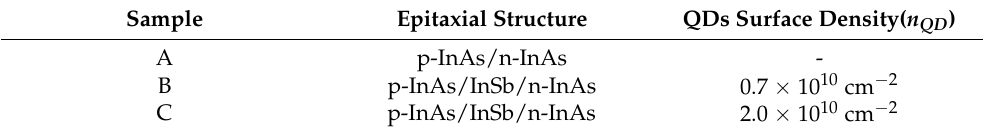
Figure 1. ( a ) AFM image of the InSb QD arrays on a surface of the InAs matrix with density n QD = 2 × 10 10 cm − 2 . ( b ) TEM image of a cross-sectional view of the InAs/InSb QDs/InAs het- erostructure. Light contrast is the position of the InSb QDs layer. Table 1. Heterostructures with QDs obtained by combined epitaxial